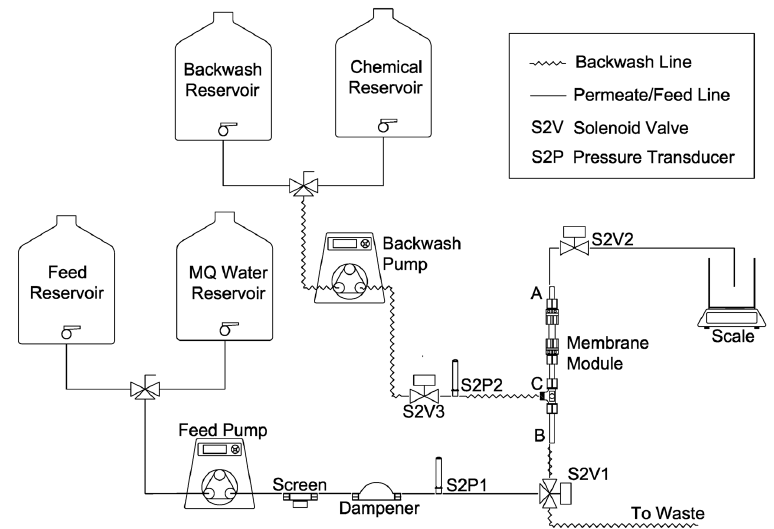
Figure 1. Inside–out filtration apparatus. Figure 1. Inside – out filtration apparatus.